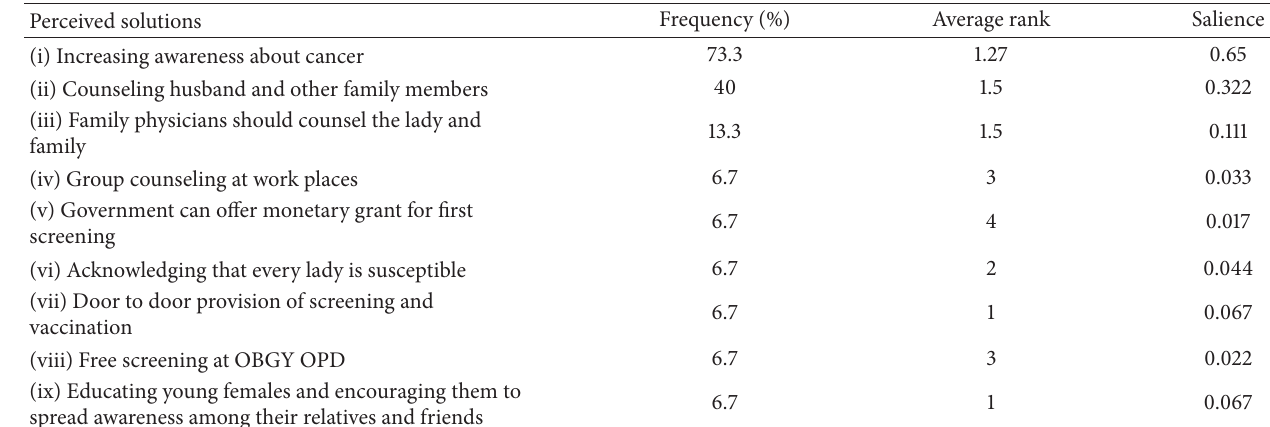
Table 9: Perceived solutions for “ casual attitude. ”